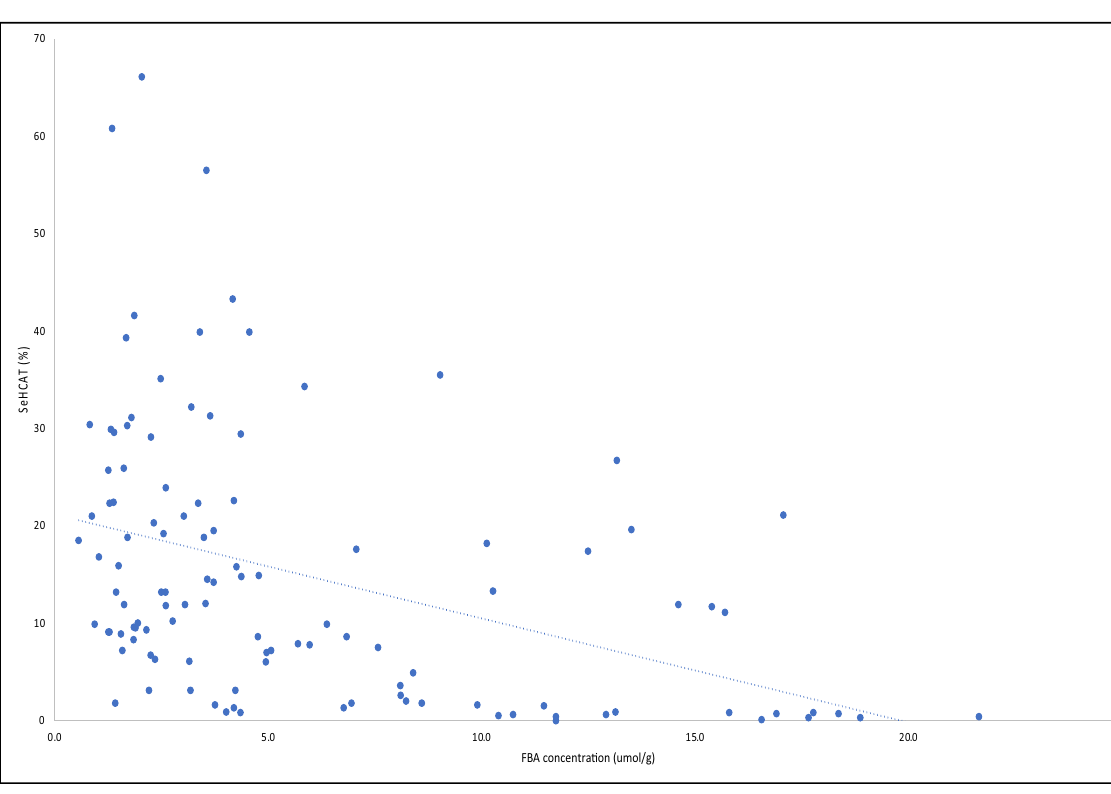
Figure 3. Spearman correlation of participants FBA concentration on enrolment to the study and SeHCAT retention